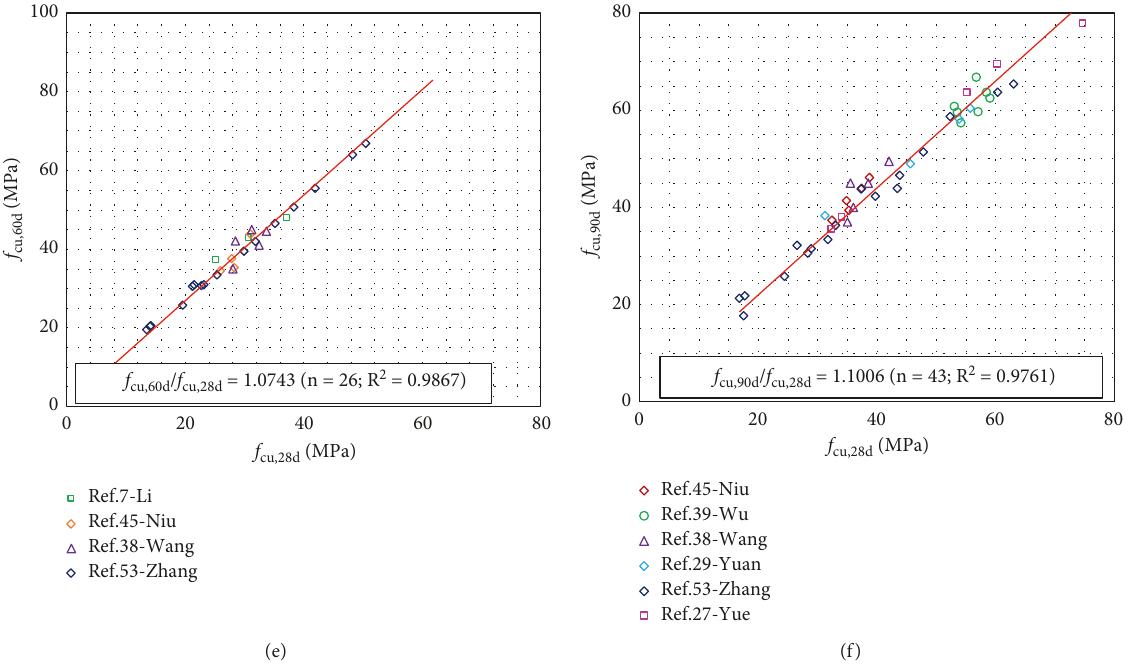
Figure 3: Relationship between compression strength at specific curing ages and that at 28 days. (a) 3 days. (b) 7 days. (c) 14 days. (d) 21 days. (e) 60 days. (f) 90